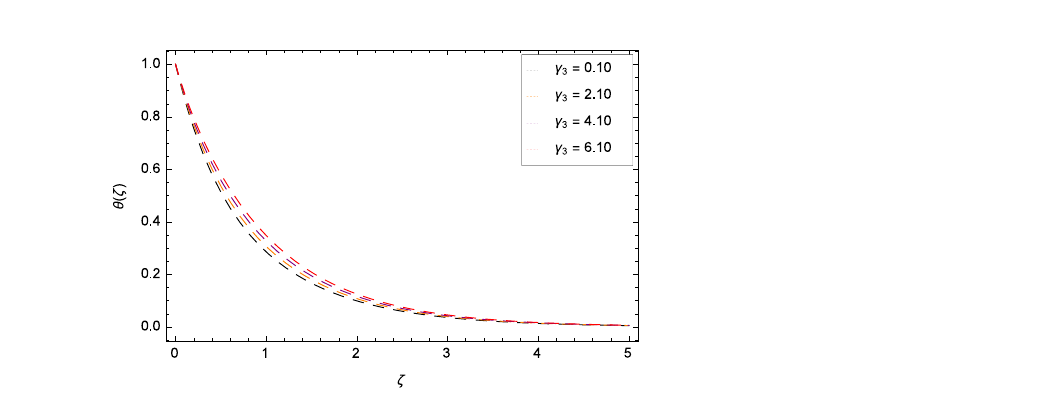
Figure 15. Pattern of graph curves on account of γ 3 .